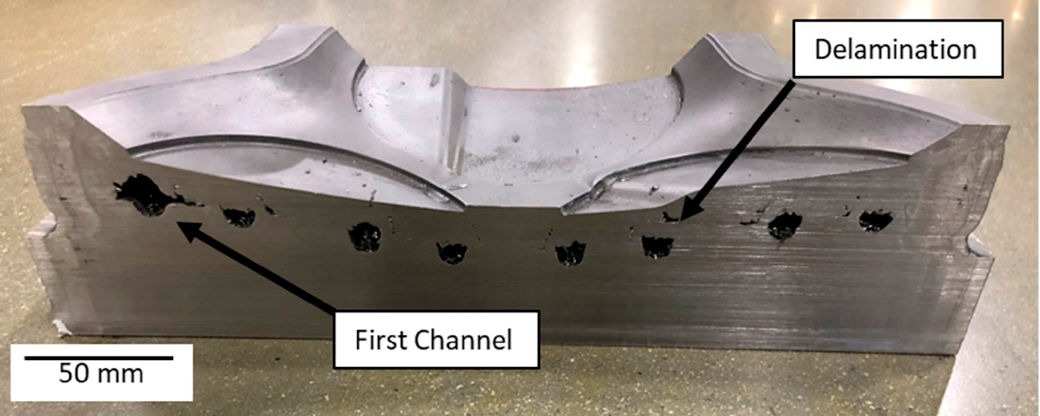
Figure 7. Mold cross-section.